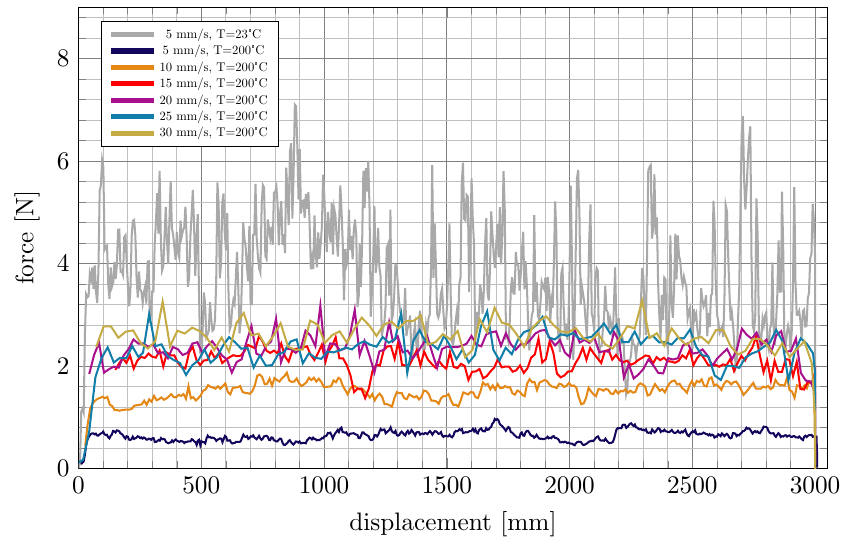
Figure 8. Deforming forces of GF-PP at room temperature (23°C), 200°C and D fe =